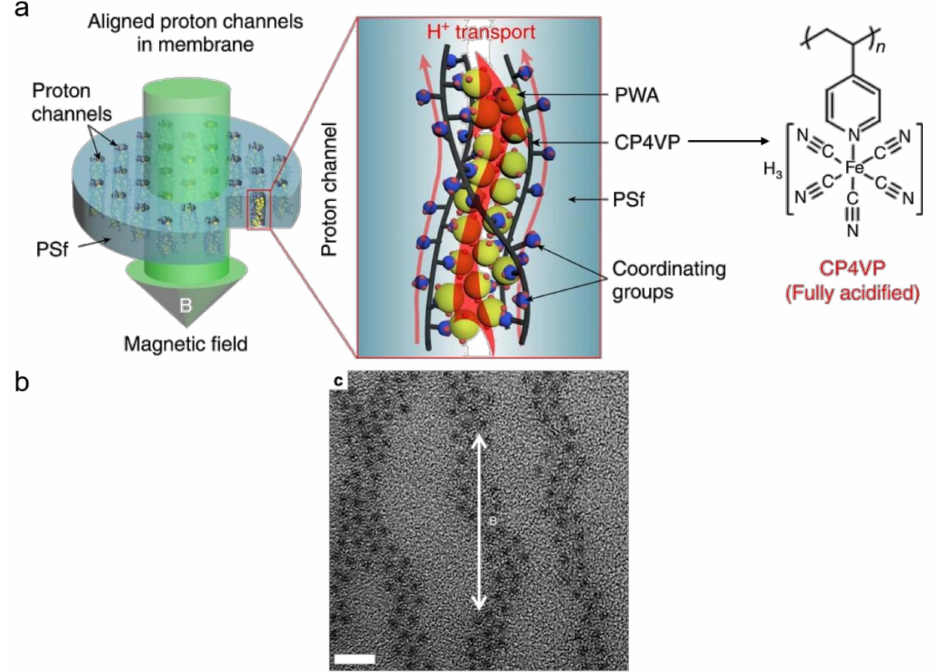
Figure 7. ( a ) Conceptual diagrams of magnetically aligned composite membrane and proton transport in the aligned channels in the membrane; ( b ) transmission electron microcsope (TEM) image for magnetically aligned composite membrane (5 nm scale bar), where the orientated chains of phosphotungstic acid (PWA) particles were clearly seen. Reproduced with permission from